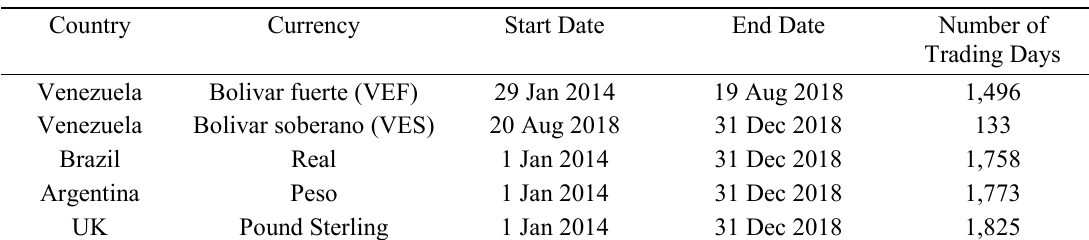
Table 1. LocalBitcoins Daily Trading Data for Venezuela, Brazil, Argentina and the United Kingdom Country